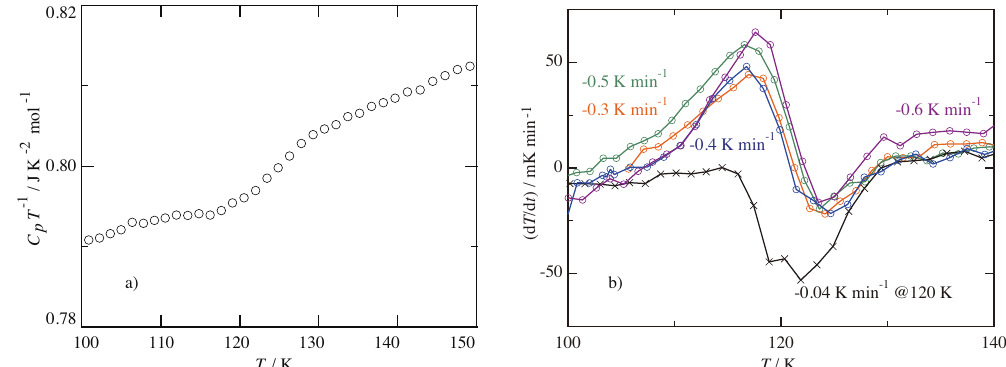
Figure 4. Experimental results in the glass transition region. ( a ) Heat capacities divided by the temperature of crystalline D -sorbose, obtained in the run from the lowest temperature (ca. 6 K). ( b ) Temperature drifts during the equilibration period observed after cooling with different rates. Indicated rates are those around 120